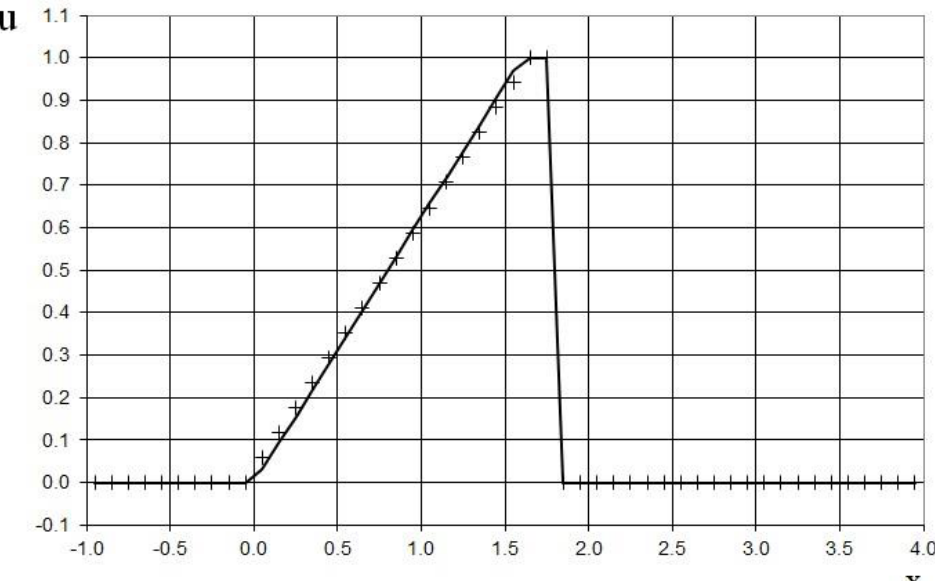
Figure 2. Velocity plot for the shock – rarefaction wave problem for the inviscid Burgers ’ equation at the time t = 1.6: the exact solution (line), and the present method (cross).